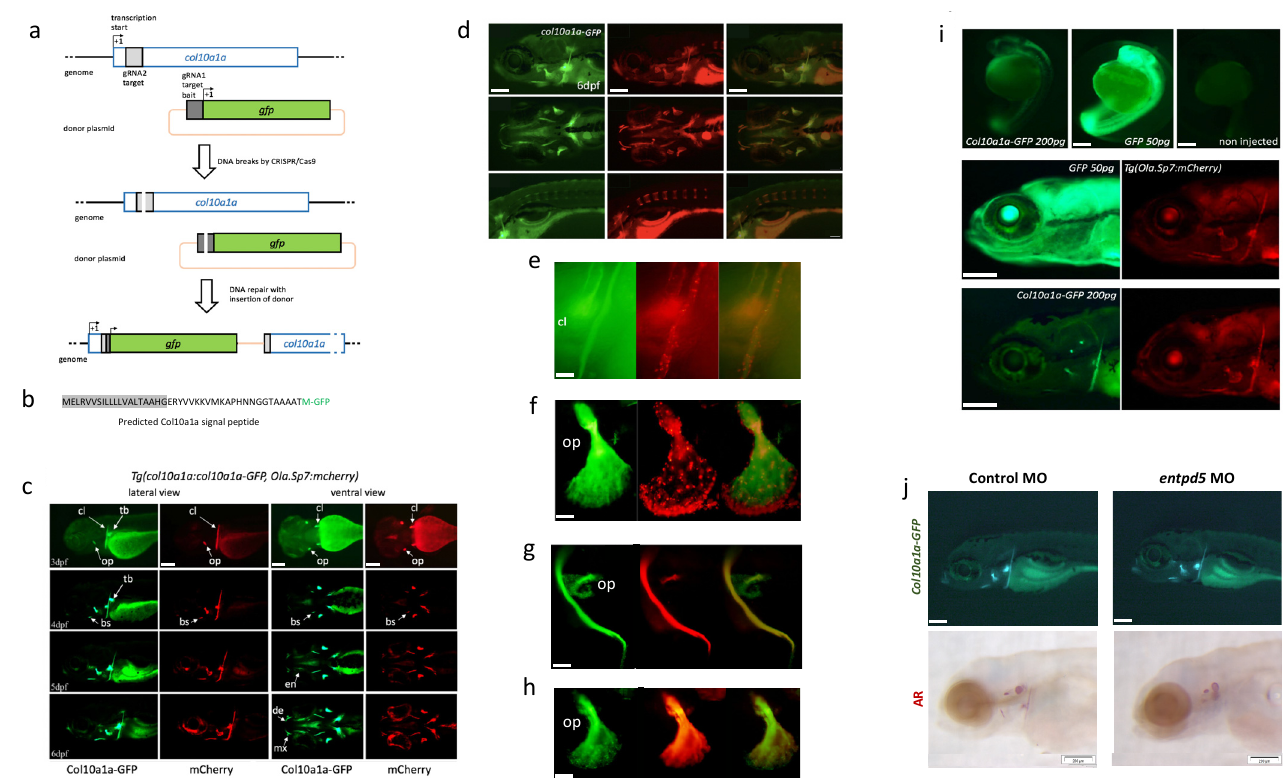
Figure 1. Characterisation of the Tg(col10a1a:col10a1a-GFP) transgenic line. ( a ) Schematic representation of the endogenous col10a1a gene (top line), the plasmids used for microinjection along with the two gRNAs (bait and col10a1a , respectively gRNA1 and gRNA2), the resulting cuts in the genomic DNA and plasmids, and the expected reporter construct in the transgenic genome. ( b ) N-terminal end of the fusion protein produced by the Tg(col10a1a:col10a1-GFP) transgenic line, with the predicted signal peptide in grey and the original GFP translational start site (M) in green. ( c ) Timeline of expression of GFP (green fluorescence) and mCherry (red fluorescence) in double-transgenic larvae Tg(col10a1a:col10a1a-GFP ; Ola.Sp7:mCherry) . Lateral and ventral views at different developmental stages as indicated, anterior to the left. White arrows point to specific elements: (bs) branchiostegal ray, (cl) cleithrum, (de) dentary, (en) entopterygoid, (mx) maxillary, (op) opercle and (tb) tooth bud. ( d ) Expression of Col10a1a-GFP protein (green) in 6 dpf Tg(col10a1a:col10a1a-GFP) larvae live-stained with AR to visualize mineralized bone. ( e – h ) Close inspection of Col10a1a-GFP localization (green) compared to mCherry expression by osteoblasts in ( e ) the cleithrum (cl) or the opercle ( f ) of 9 dpf Tg(col10a1a:col10a1a-GFP ; Ola.Sp7:mCherry ) zebrafish larvae. ( g, h ) Expression of GFP protein (green) in Tg(col10a1a:col10a1a-GFP ) 6 dpf larvae live-stained with AR to visualize bone matrix. Close inspection of the cleithrum ( g ) and the opercle ( h ). ( i ) Zebrafish Tg(Ola.Sp7:mCherry) larvae after microinjection of mRNA coding for GFP or for the fusion protein Col10a1a-GFP. Top: embryos at 1 dpf, showing weak fluorescence of Col10a1a-GFP, extremely strong fluorescence of GFP, and no fluorescence in controls. Bottom: the same larvae at 5 dpf, still showing strong GFP expression in the entire body and weak, but specific fluorescence of Col10a1a-GFP located in bone elements (cleithrum and opercle) as confirmed by the red fluorescence of osteoblast-specific mCherry. ( j ) Morpholino injection into Tg(col10a1a:col10a1a-GFP ) larvae. The Col10a1a-GFP protein labels cranial bone elements at 4 dpf in both control and entpd5 MO injected larvae (top), but AR staining is absent in entpd5 morphants (bottom). The scale bars, given in the left bottom corner of the images, represent 200 µm, except for e-h, where they indicate 20 µm.